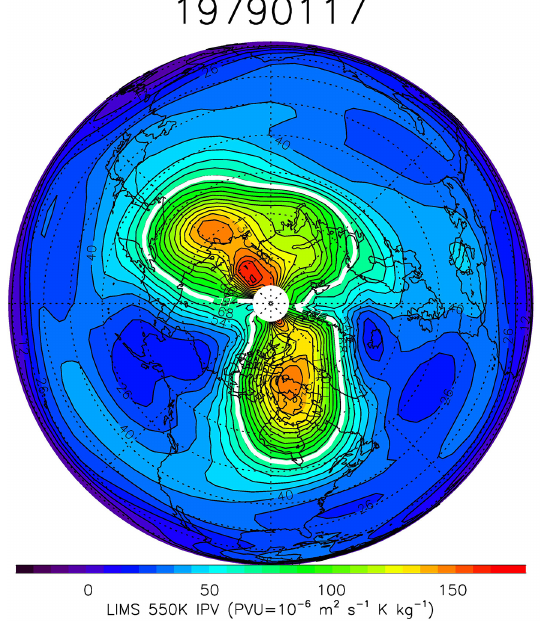
Figure 15. Isentropic potential vorticity (PV) at 550K for 17 Jan- uary 1979. Units of PV are in terms of (10 − 6 m 2 s − 1 Kkg − 1 ) , and contour interval (CI) is 7 units. The thick white contour denotes the polar vortex edge as defined using Nash et al. (1996).